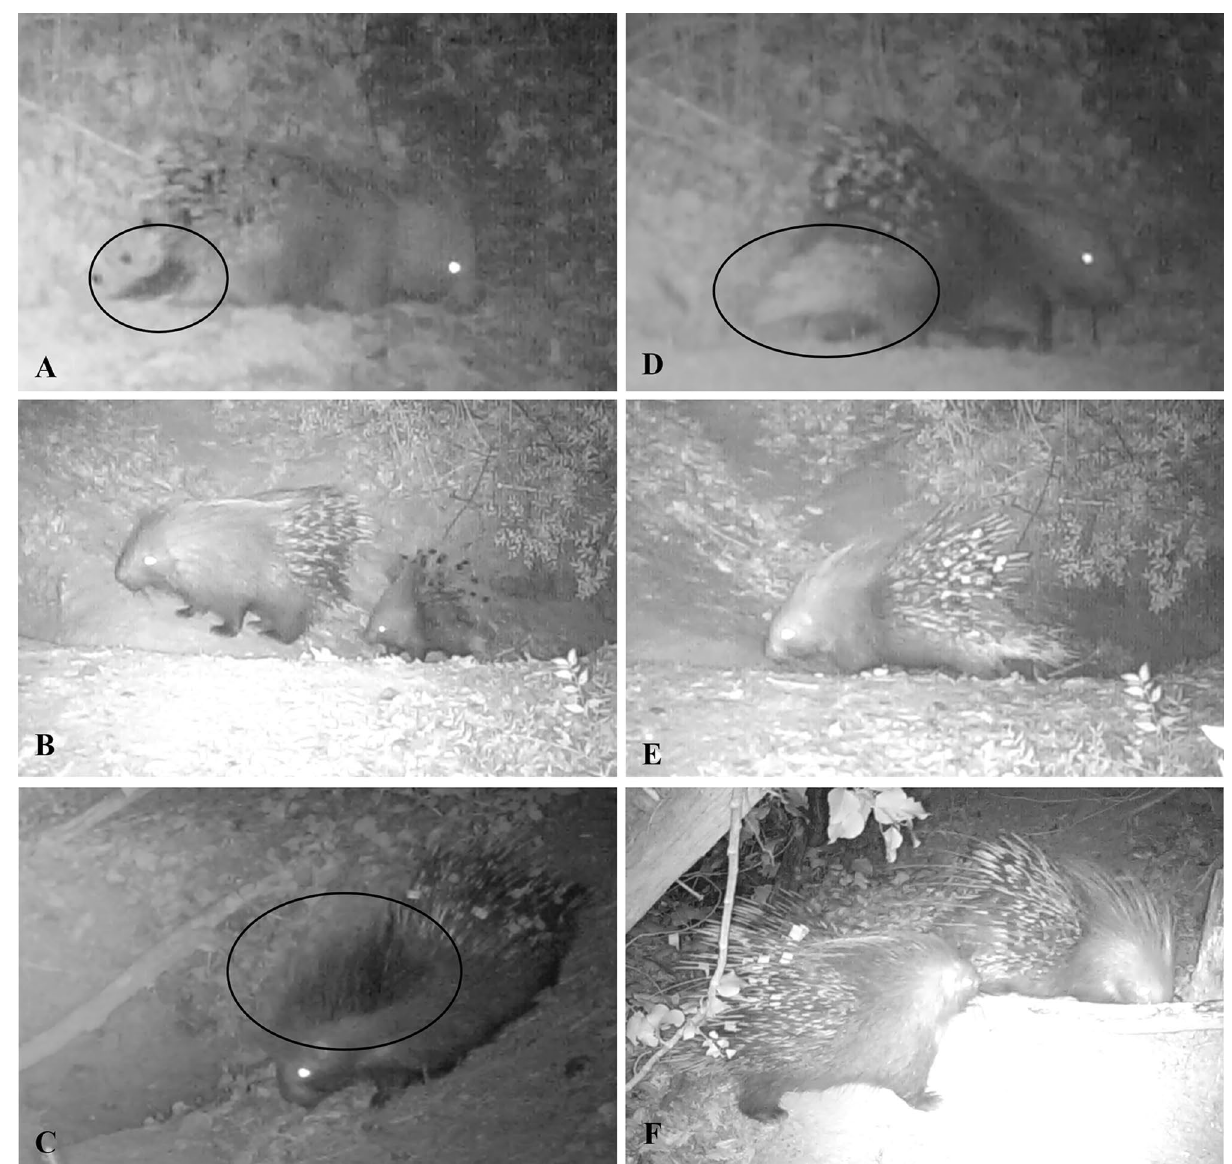
Figure 5. Screenshot of camera traps videos of some marked porcupines. ( A ) Adult male of family 4 in S4 marked with black tapes on quills and black paint on the tail (in the circle). ( B ) Porcupettes female of family 6 in S10 marked with black tape on quills. ( C ) Sub-adult female of family 1 in S1 marked with red tapes (visible as grey tape in greyscale camera trap videos) on quills and black paint on the crest (in the circle). ( D ) Sub-adult female of family 4 in S4 marked with red tapes (visible as grey tape in greyscale camera trap videos) on quills and white paint on the tail (in the circle). ( E ) Sub-adult female of family 6 in S10 marked with white tapes on quills. ( F ) Adult male of family 5 in S9 marked with white tapes on holes used by porcupines (see Supplementary Table S2). All experimental settlements were in steep sandy soil in deciduous woodlands, within a range of 80 m from either cultivated or non-cultivated areas. The average distance between the settlements was 2.6 km (standard deviation (SD) = 1.4 km) and the minimum distance was 120 m. The distance between the settlements and the environmental characteristics (i.e., presence of gorge, streams, street, path etc.) excluded the presence of any direct underground connection between each pair of settlements. The inhabitation of settlements by crested porcupine was determined by assessing the time of permanence in the burrow in each day of monitoring. The settlements were considered inhabited if the permanence of a porcupine family in the burrow during daytime was confirmed. The permanence was defined as daytime continuously spent by porcupine either inside or in front of the burrow (e.g., performing sunbathing and/or lactation) being longer than the minimum recorded time interval between the last coming in and the first coming out from the burrow 25 . The days when permanence in the settlements could not be determined were excluded from the analysis. For each porcupine family, the number of settlements inhabited, the days of inhabitation in each settlement and the